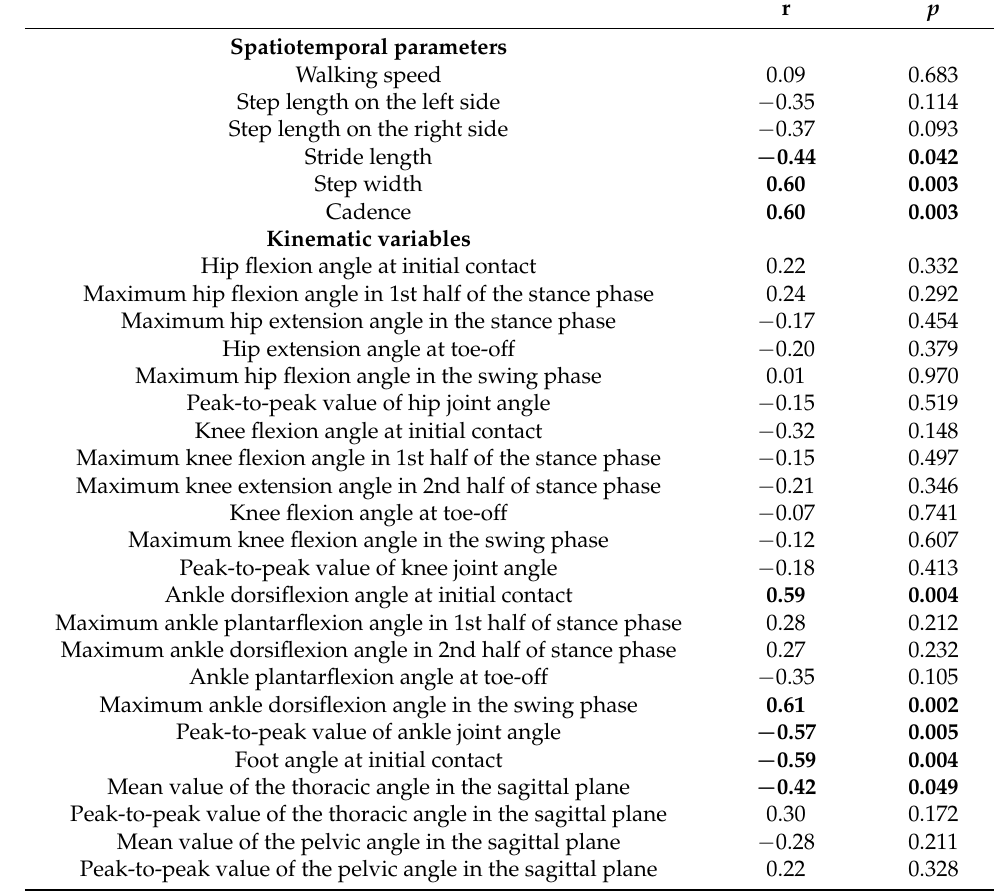
Table 5. Spearman’s rank correlation analysis for age and floor surface-related changes in gait